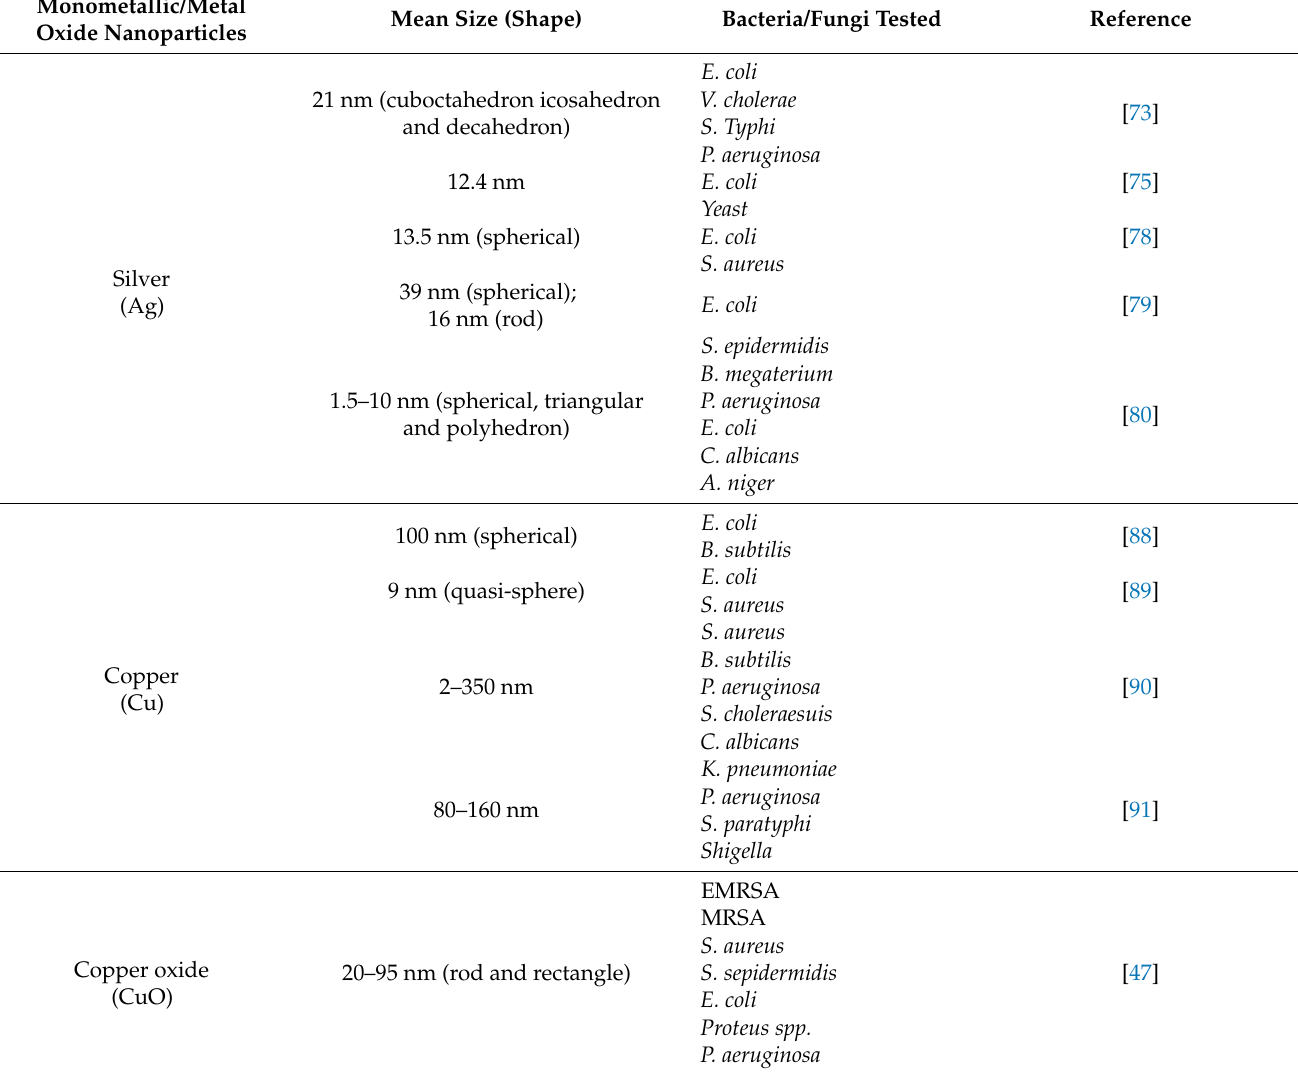
Table 1. Summary of nanoparticles that have been tested for antimicrobial activity.